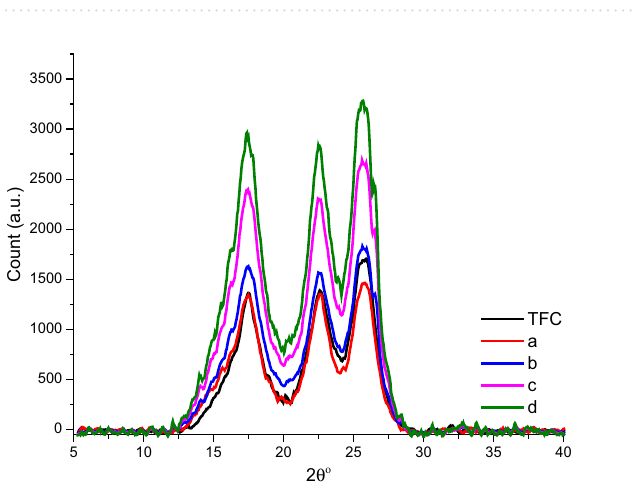
Figure 6. ATR-FTIR of PS, TFC and ( a – d ) TFN-Al 2 O 3 membranes with varied fractions of mesoporous γ-Al